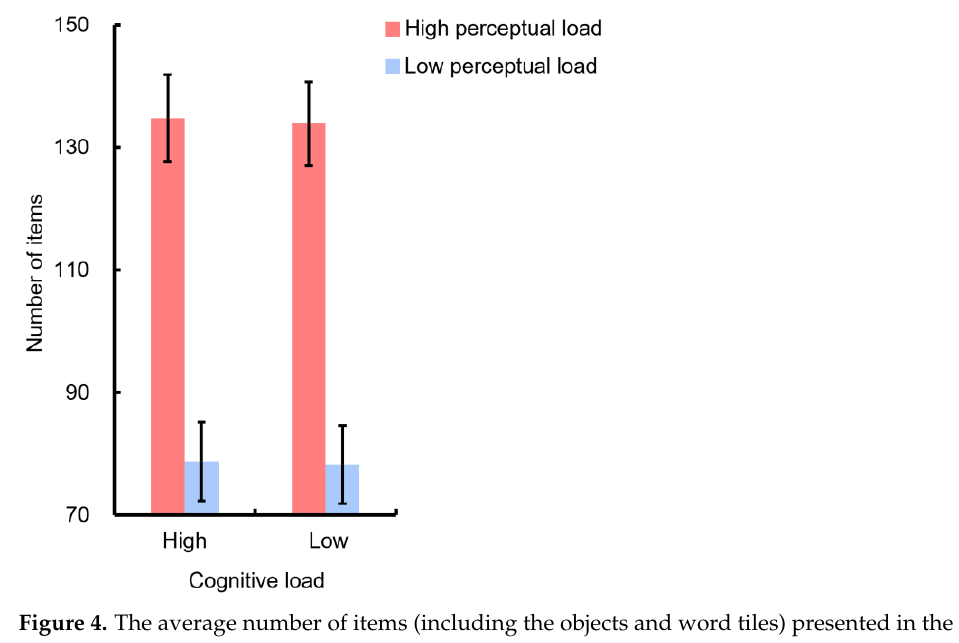
Figure 3. An example of the four mental workload conditions adopted in the experiment.